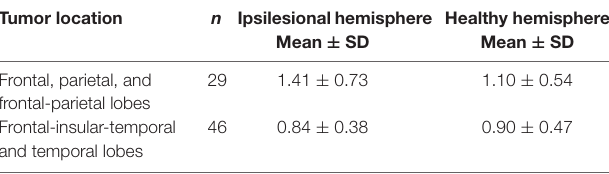
TABLE 3 | Activation peak shifts in tumor location subgroups. Tumor location